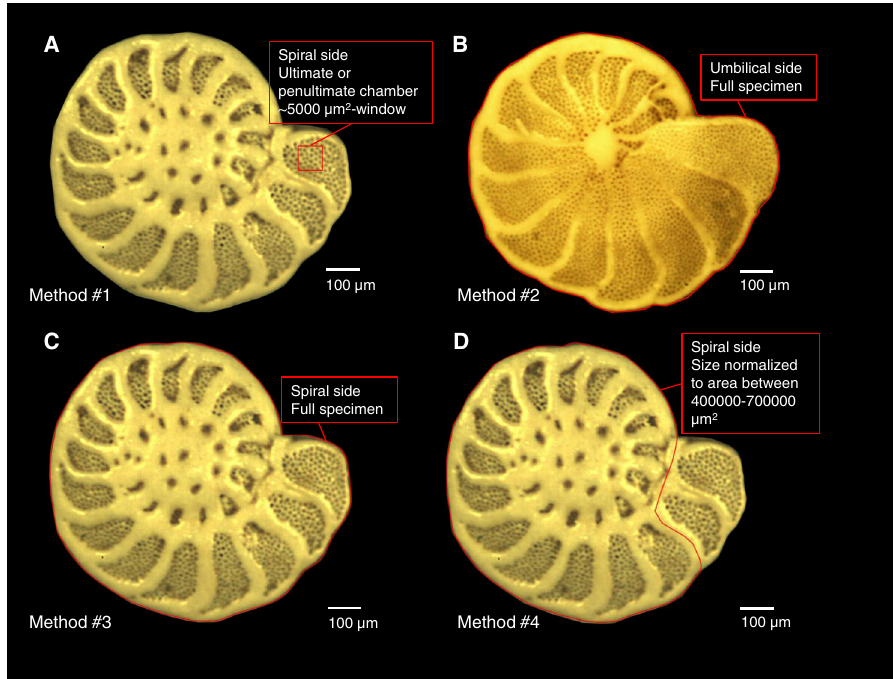
Fig. 3 Visual descriptions of pore density (PD) determination methods. Visual description of the four methods that have been compared to determine the PD of Planulina limbata . For a detailed description of these methods see text. A Method #1; B Method #2; C Method #3; D Method